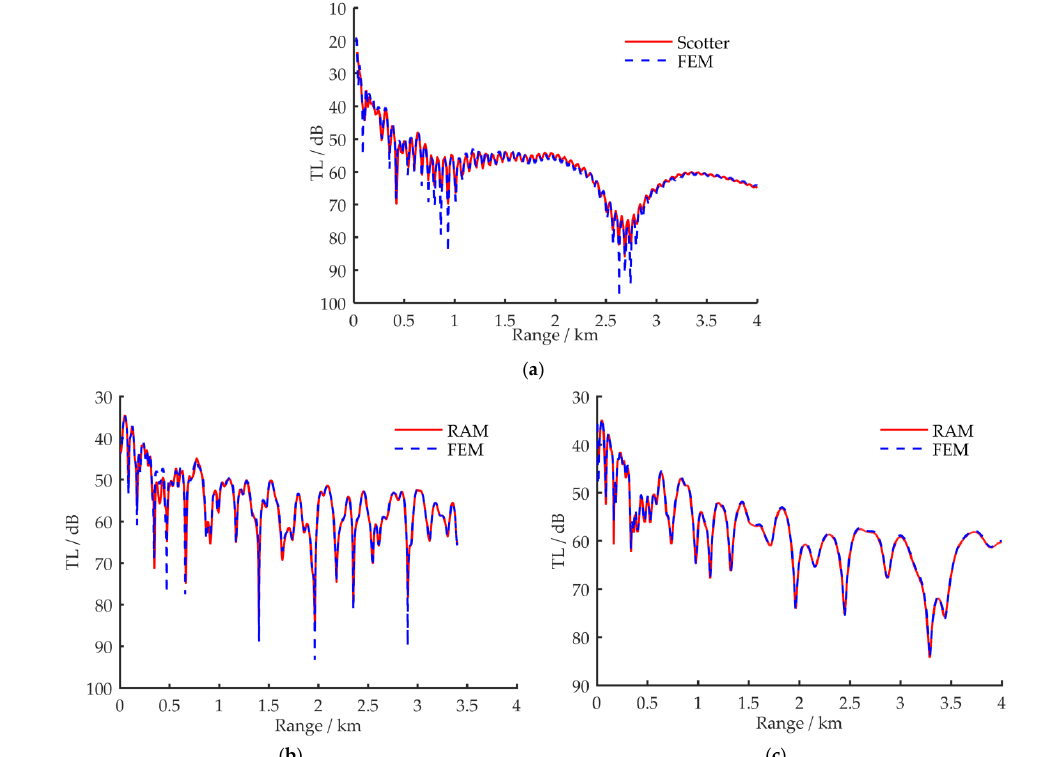
Figure 3. The comparison of the sound pressure Transmission Loss (TL) curves between FEM and other sound field simulation methods. ( a ) Comparison results between FEM and the fast field method under the simulation condition in Figure 2a; ( b ) comparison results between FEM and the coupled normal wave method under the simulation condition in Figure 2b; ( c ) comparison results between FEM and the parabolic equation method under the simulation condition in Figure 2c.